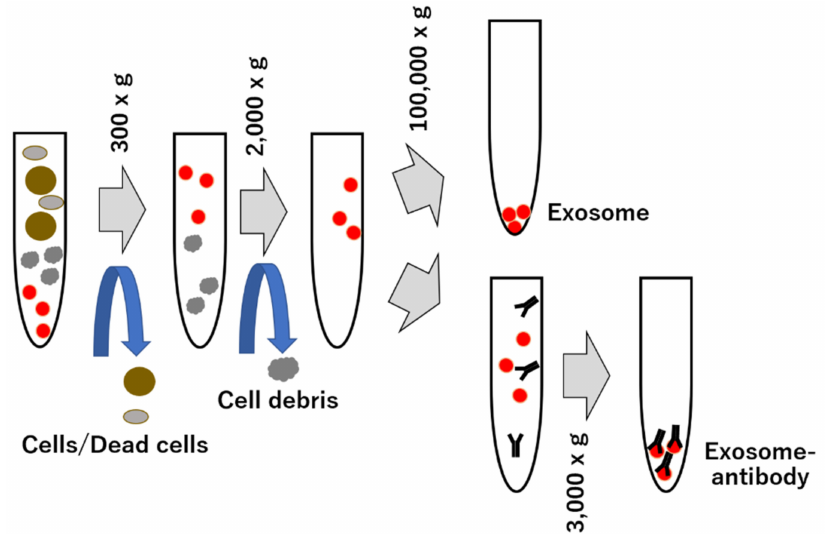
Figure 3. The exosome purification by ultracentrifugation and immunoprecipitation using antibody. Contents in solution from supernatant of culture cells and blood samples are isolated by sequential centrifugation with different centrifugation speeds. In addition, some antibodies for some antigens on surface membrane of exosome can bind and isolated via association between exosome and